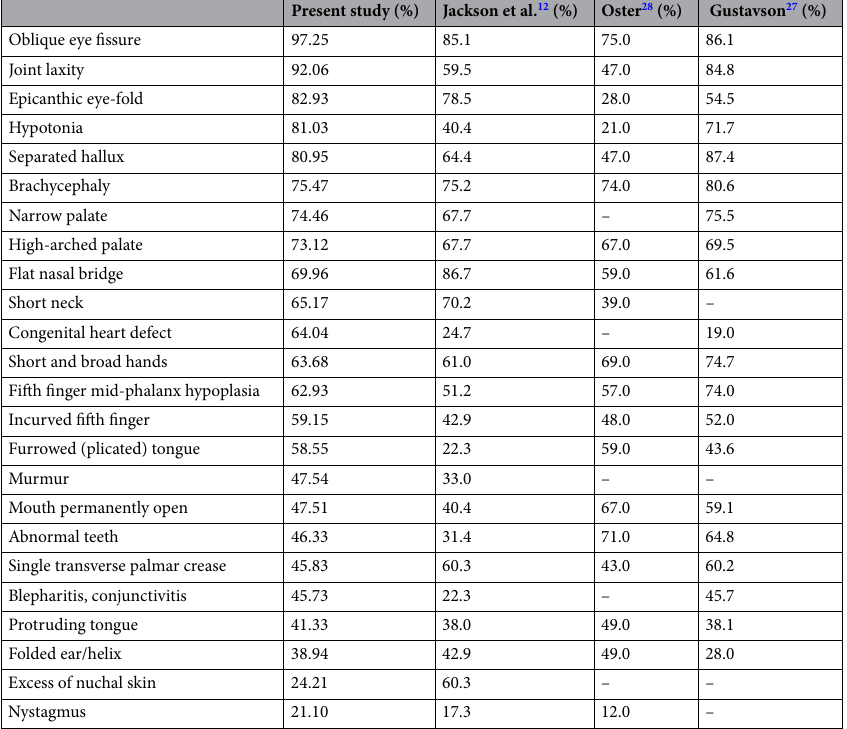
Table 2. Physical sign frequencies in subjects with DS found in the present study compared with previous works. Brushfield spots feature was excluded. Signs are sorted by decreasing frequency found in the present study. Frequencies are expressed as percentages.